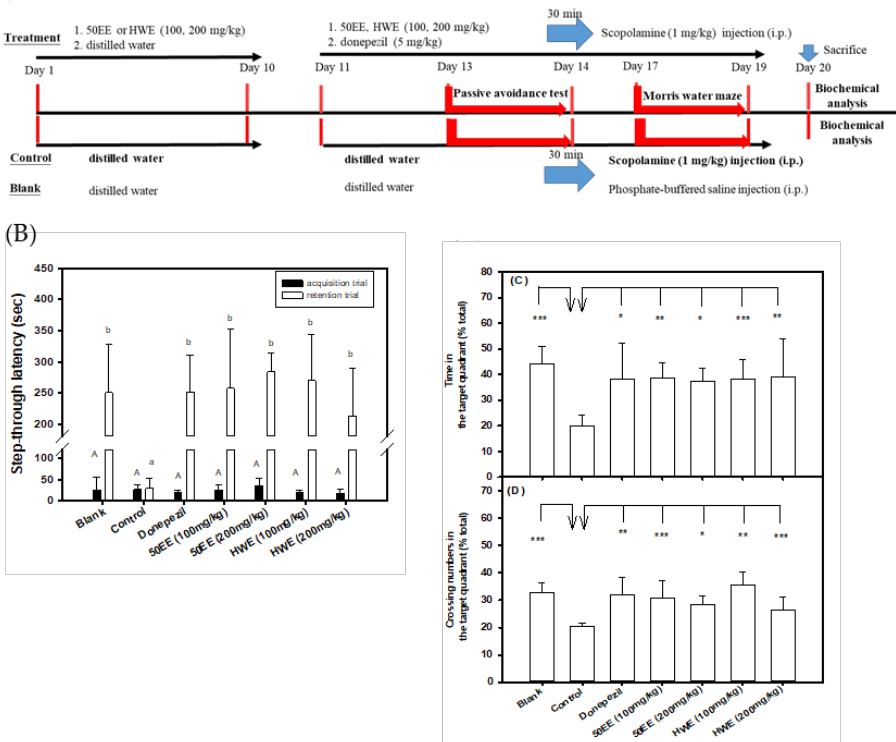
Figure 4. Effects of TT-hull-50EE or TT-hull-HWE (100 and 200 mg/kg) treatments on improvements in learning and memory functions in scopolamine-induced amnesiac mice (six heads/group). ( A ) The experimental protocol, which included four treatment groups, one donepezil-positive control group, one control group, and one blank group; ( B ) the step-through latency (sec) in the passive avoidance test; ( C ) the swimming time in the target quadrant (% of total) in the probe test of the Morris water maze; ( D ) the crossing numbers in the target quadrant (% of total) in the probe test of the Morris water maze. The mice in the control group were injected with scopolamine only in the parallel experiment. Comparisons among multiple groups in the step-through latency ( B ) were performed using one-way analysis of variance (ANOVA) and the post hoc Tukey’s test, and the different uppercase letters in the step-through latency in the acquisition trial or the different lowercase letters in the retention trial were considered significantly different ( p < 0.05) among groups. Student’s t-test was used to compare the treated groups with the control group in the probe test of the Morris water maze ( C , D ), and any difference was considered statistically significant when p < 0.05 (*), or p < 0.01 (**), or p < 0.001